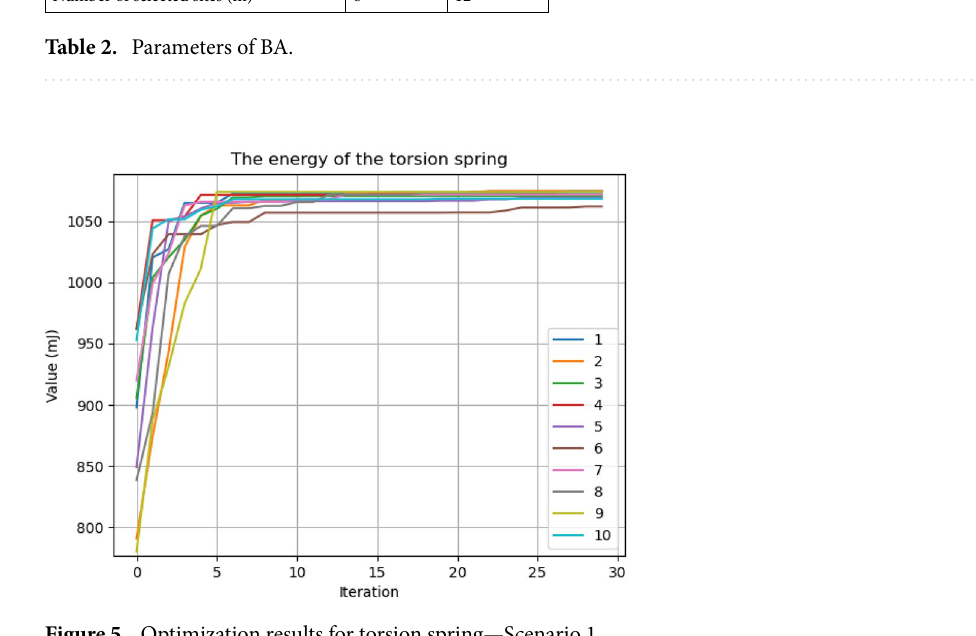
Figure 5. Optimization results for torsion spring—Scenario